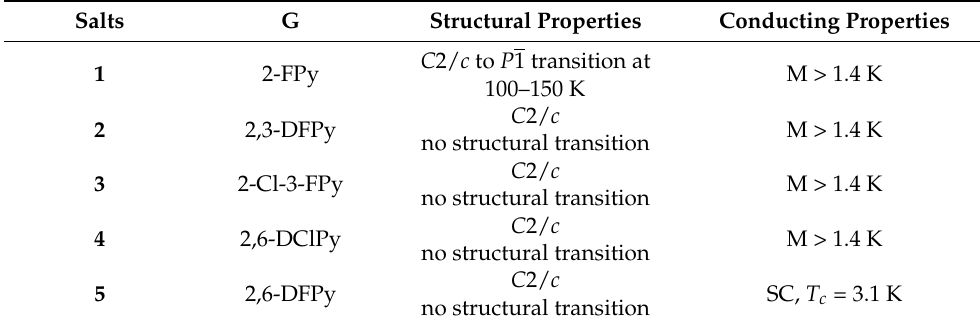
Table 2. The β (cid:48)(cid:48) -(BEDT-TTF) 4 (NH 4+ )[Fe(C 2 O 4 ) 3 ]G salts obtained and their properties. Salts G Structural